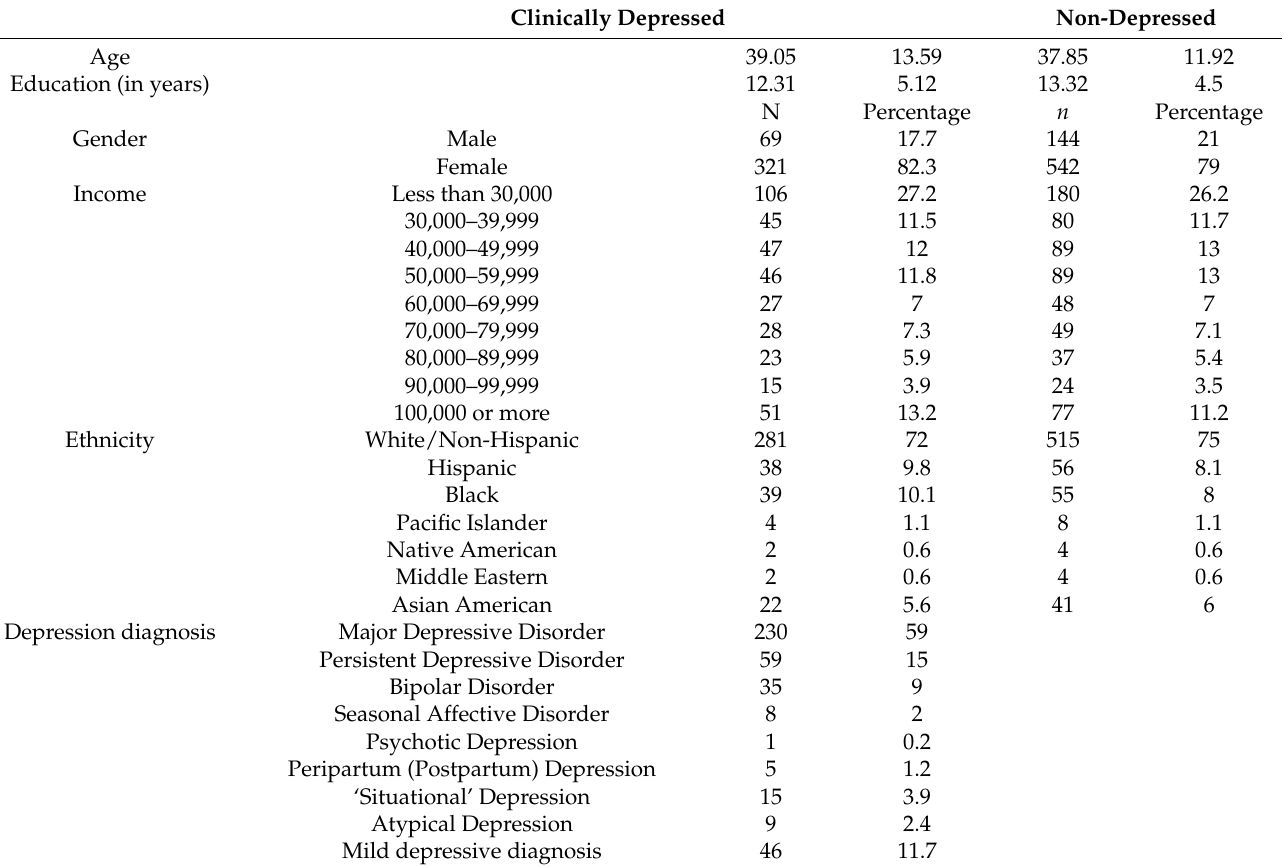
Table 2. Demographic information of participants: age, gender, income, ethnicity, and depression diagnosis.